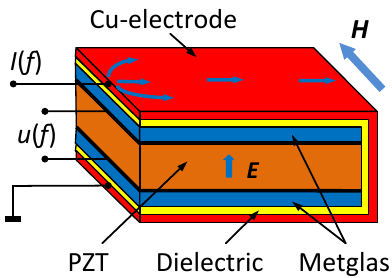
Figure 16. Schematic view of a Cu/Metglas-PZT-Metglas/Cu heterostructure with integrated "magnetic capacitor" excitation system. The arrows show directions of electric E and magnetic H fields.